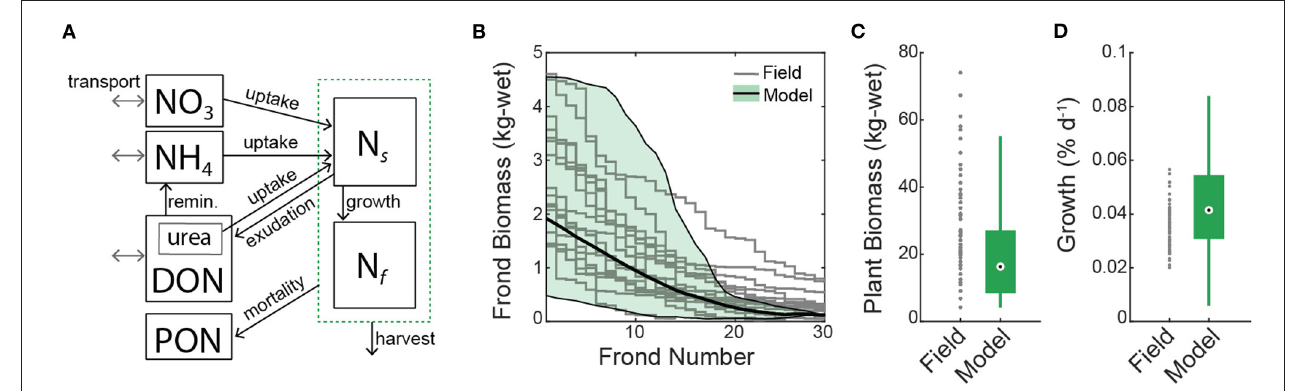
FIGURE 3 | (A) Conceptual diagram of the macroalgal growth model. Nitrogen is partitioned between seawater and macroalgae (green dashed box). Transformation pathways among state variables are indicated (black lines with arrowhead). Dissolved nutrients undergo transport (gray lines with arrowheads). N s , stored nitrogen in macroalgae; N f , fixed nitrogen in macroalgae; DON, dissolved organic nitrogen in seawater; PON, particulate organic nitrogen in seawater. (B–D) Comparison of the macroalgal growth model with field surveys of Macrocystis pyrifera conducted by the Santa Barbara Coastal Long Term Ecological Research Program at Mohawk Reef. (B) Field measurement of the distribution of biomass (kg-wet) among fronds from a single plant [gray lines; n=17 plants; Reed and Rassweiler (2018)] compared with daily frond biomass predicted by the model (solid black line is the average and full range in shaded green). (C) Total plant biomass from surveyed plants compared with the model. (D) Field-derived growth rates compared with daily growth rates from the model [Equation (20)]. Box plots are median, upper and lower quartiles, and maximum and minimum values.